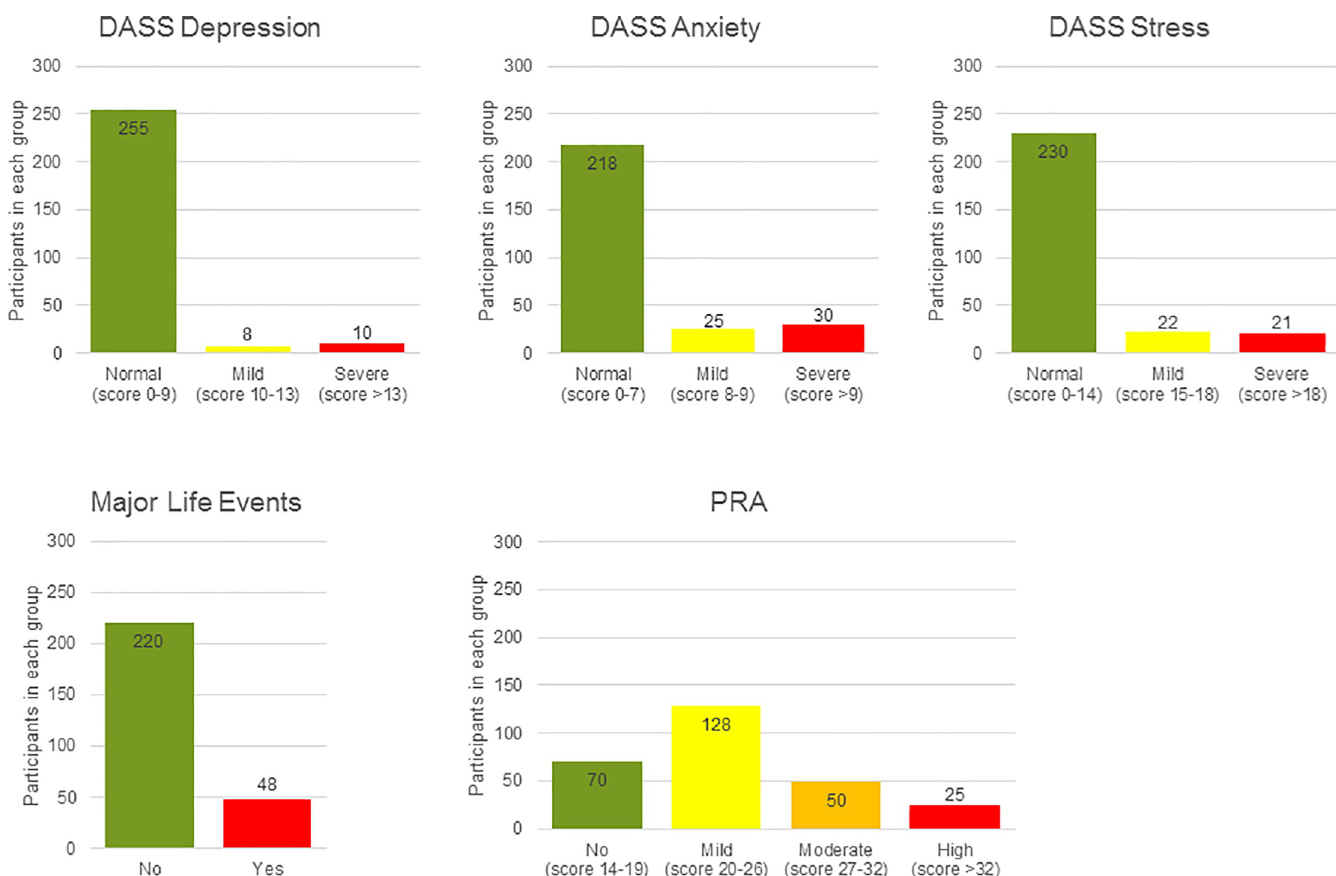
Fig 2. Categorical distribution of the study population based on DASS scores, Major Life Events and PRA. The study population divided into groups according to severeness of maternal (A) Depression, (B) Anxiety and (C) Stress based on the Depression Anxiety and Stress Scales, (D) Major Life events and (E) Pregnancy related anxiety